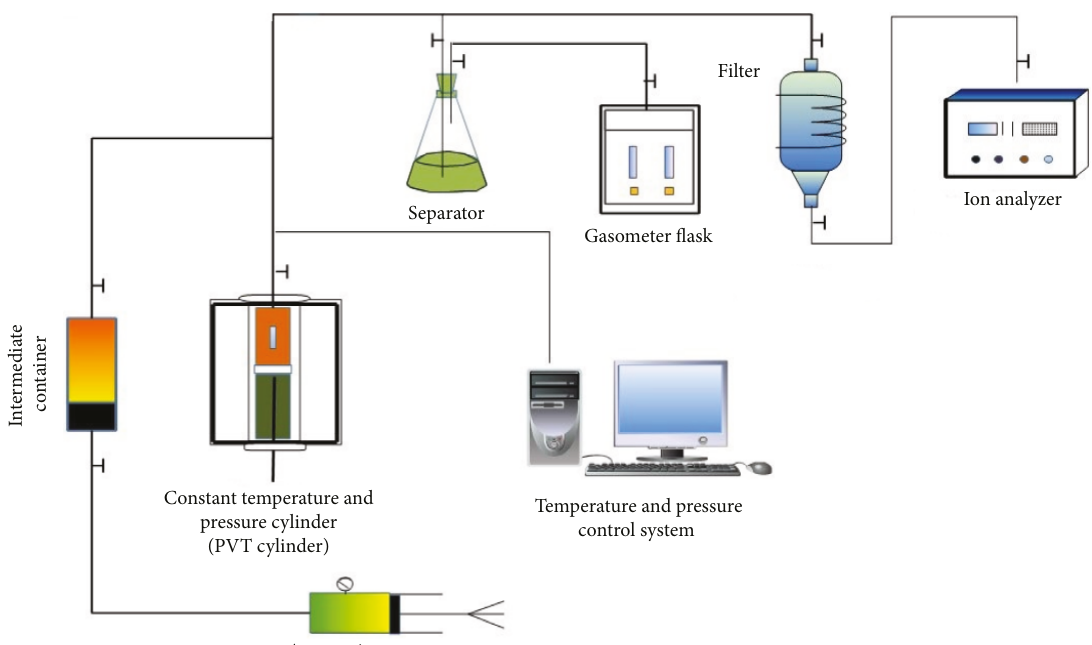
Figure 1: Scaling test device under the high temperature and